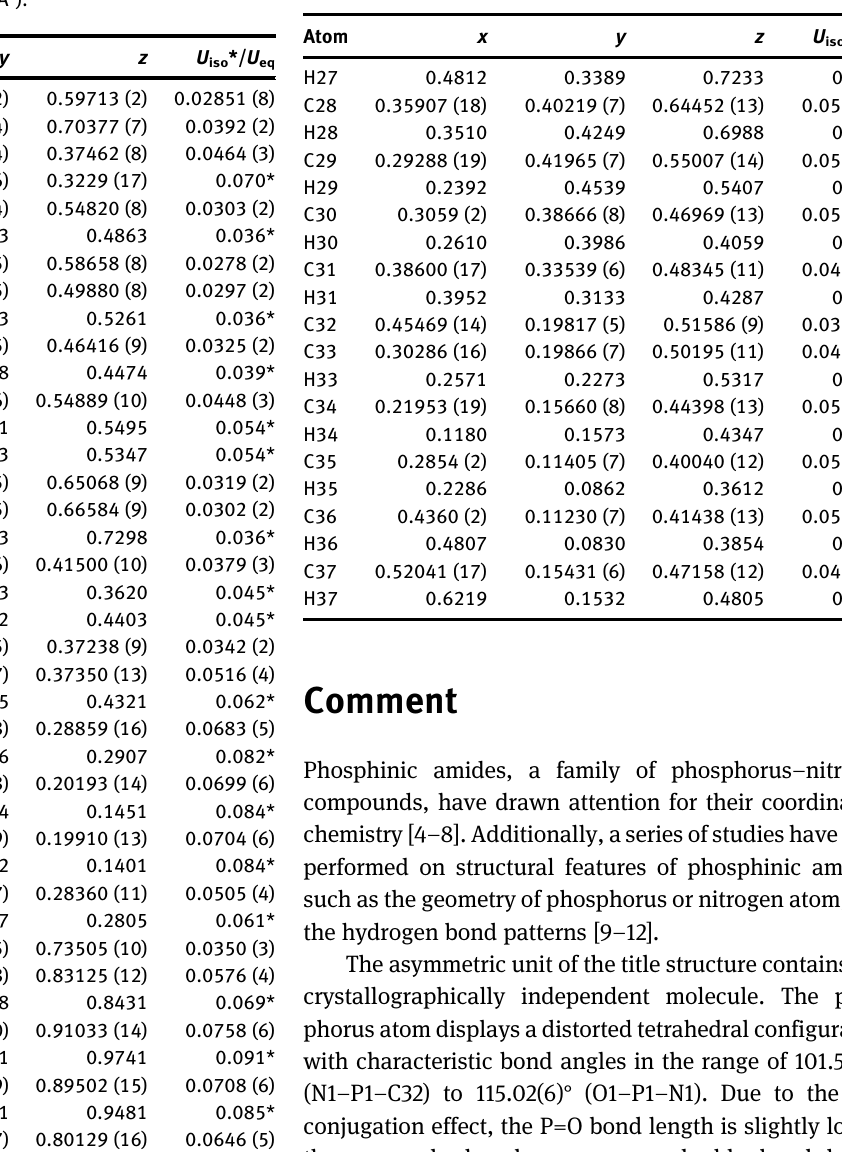
Table  : Fractional atomic coordinates and isotropic or equivalent isotropic displacement parameters (Å 